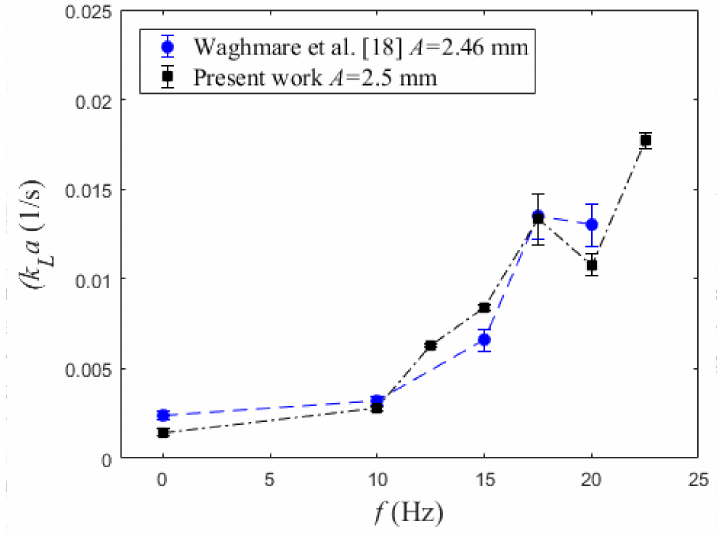
Figure 14. Comparison of k L a versus f with data from Waghmare et al. [18], U SG = 2.5